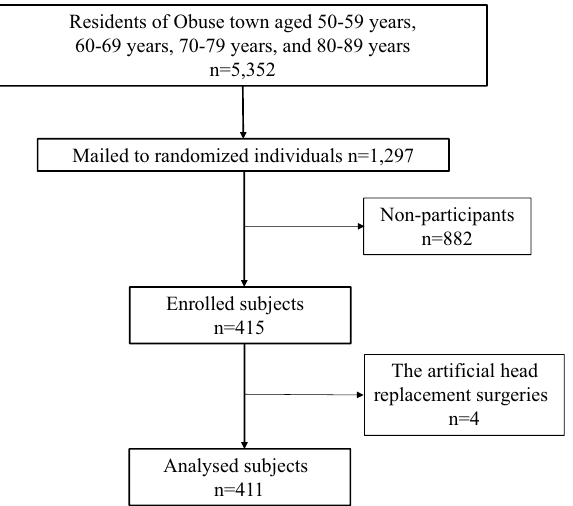
Figure 1. Obuse town resident participant flowchart. 1297 people were randomly sampled from 5352 residents aged between 50 and 89 years in the basic resident registry of Obuse town. A total of 415 people joined the Obuse study cohort, but 4 were excluded due to the artificial head replacement